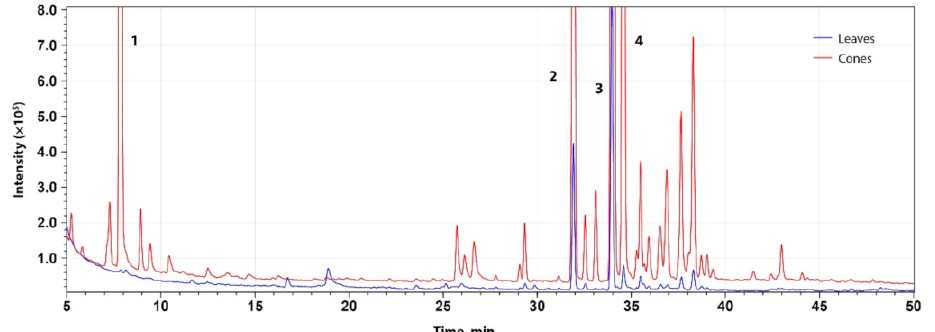
Figure 1. Gas chromatogram and characteristic volatile compounds of supercritical fluid extracts of leaves and cones of ‘Fredos derlingieji’ (1— β -myrcene; 2— β -caryophyllene; 3— α -humulene; 4— β